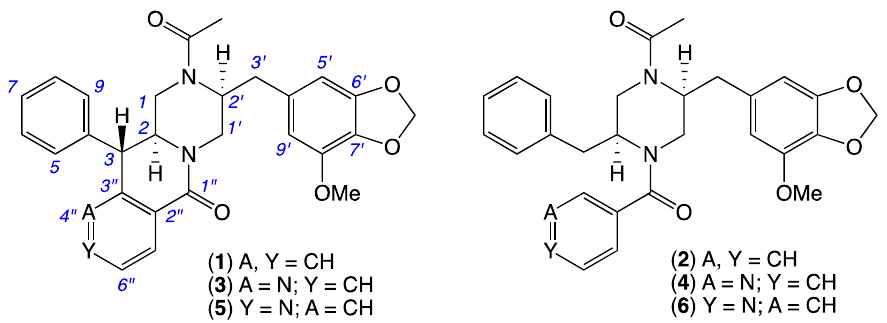
Figure 3. New chrysosporazines 1 – 6 from Aspergillus sp. CMB-F661.